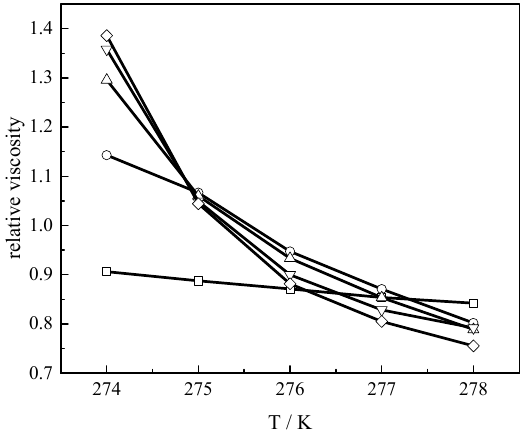
Figure 8. Relative viscosities of slurries (equilibrium slurry viscosities divided by viscosity of gas-free water-in-oil emulsions with the same temperature and water cut) versus temperature for annealed hydrate slurry with AA-2 formed at 278.2 K with initial pressure of 6.0 MPa and stirring speed of 300 rpm and a water cut of ( □ ) 5%; ( ○ ) 10%; ( △ ) 15%; ( ▽ ) 20%; ( ◊ ) 25%. Lines are provided to guide the eye.